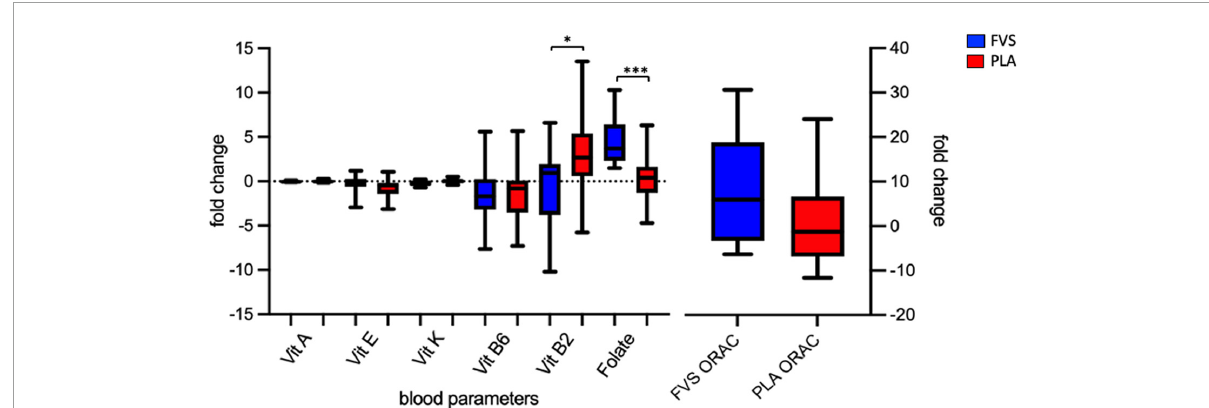
FIGURE1 Serum biomarkers of the antioxidant capacity. Serum levels of vitamins A, E, K, B6, and B2 and folate, and antioxidant capacity in the FVS group (blue bars) and PLA group (red bars). The median and interquartile (IQR) ranges are showed in the box plots. FVS, N = 15, PLA, N = 14. ∗ p < 0.05 and ∗∗∗ p < 0.001 when compared with the PLA group using the unpaired t-